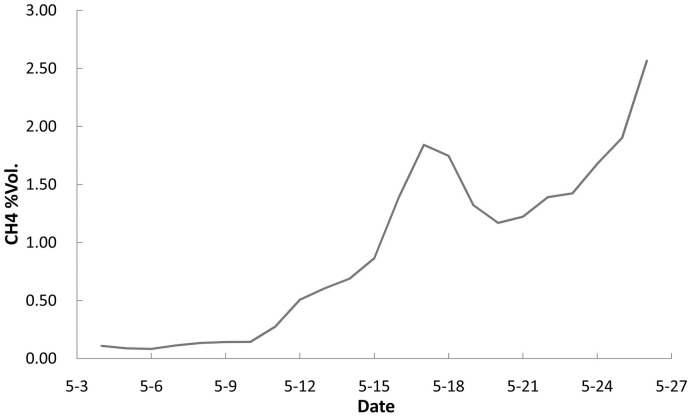
Methane volume concentration changes in a methanogenic consortium cultured with nutrition solution #1 at 39°C and pH 6.40.The contents of the solution were (in g/L) NaHCO3, 0.20; NH4Cl, 1.00; NaH2PO4, 1.30; KCl, 0.50; MgSO4•7H2O, 0.20; CaCl2•5H2O, 0.10; yeast extract, 0.50; resazurin, 0.10.